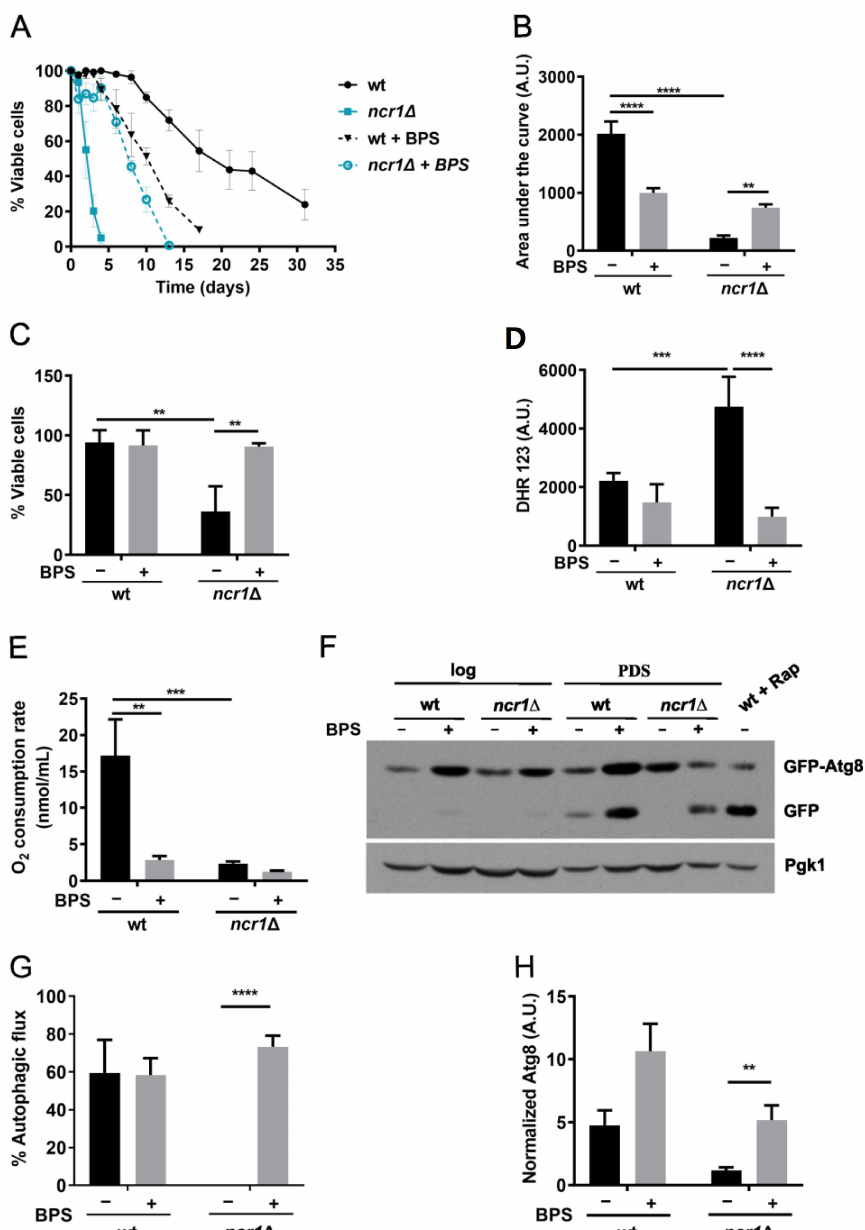
Figure 6. Chelating iron with BPS increases the chronological lifespan, oxidative stress resistance, and autophagic flux of ncr1 ∆ cells. ( A ) Wild-type and ncr1 ∆ cells were grown to post-diauxic shift [(PDS), 24 h after log] phase and maintained overtime in SC medium (wt, ncr1 ∆ ) or SC medium supplemented with 80 µ M of BPS (wt + BPS, ncr1 ∆ + BPS). Cellular viability was expressed as the percentage of the colony-forming units in relation to day 0. Data are the mean ± SEM of at least three independent experiments. ( B ) The area under each lifespan curve was computed using GraphPad in arbitrary units (A.U.). Data are the mean ± SEM. ** p ≤ 0.01; ****, p ≤ 0.0001 (one-way ANOVA). ( C ) Cells were grown to PDS (24 h after log) phase in medium supplemented or not with 80 µ M of BPS and exposed to 5 mM H 2 O 2 for 1 h. Cell viability was measured as the percentage of the colony-forming unit (treated cells vs. non-stressed cells). Values are the mean ± SD. ** p ≤ 0.01 (two- way ANOVA). ( D ) Cells were grown to PDS (48 h after log) phase in medium supplemented or not with 80 µ M of BPS and intracellular reactive oxygen species were analyzed by flow cytometry, using Dihydrorhodamine 123 (DHR123) as probe. Data are the mean ± SD. *** p ≤ 0.001; **** p ≤ 0.0001 (two-way ANOVA). ( E ) Cells were grown to PDS (24 h after log) phase in medium supplemented